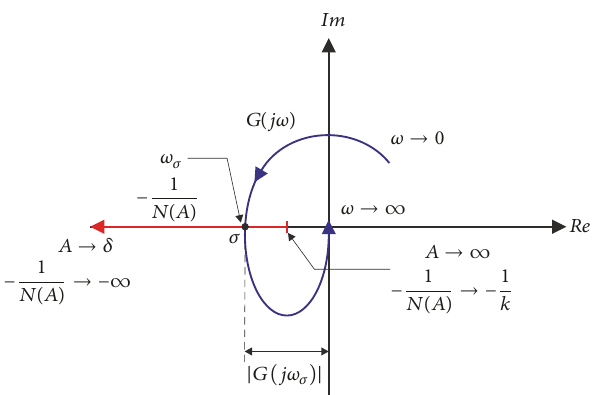
Figure 6: Polar plot of 𝐺(𝑗𝜔) and −1/𝑁(𝐴)